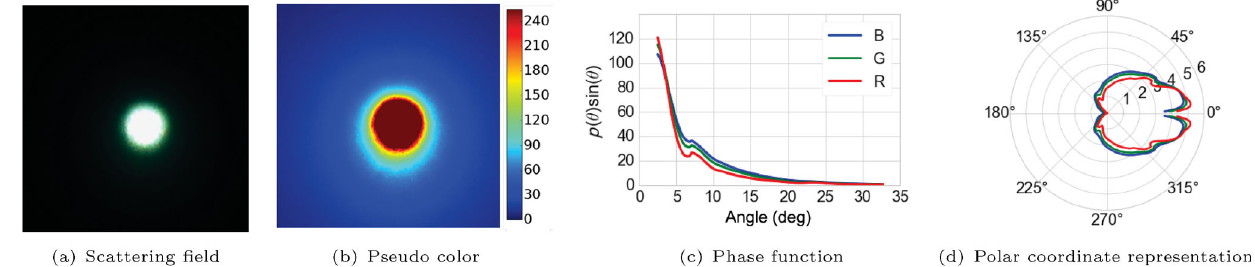
Fig. 5 Experimental result for milk. (a) Scattering field captured through screen at bottom. (b) Pseudo-color of captured scattering field. (c) Measured phase function versus scattering angle. (d) Polar plot of phase function. The incident direction is from left to right and intensity is given on a log scale.